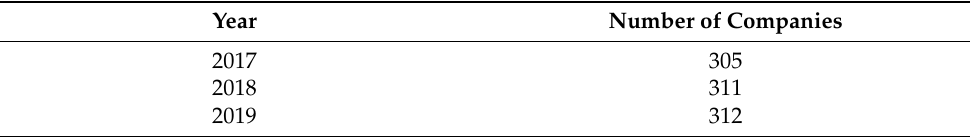
Table 1. Number of businesses included in the analysis by